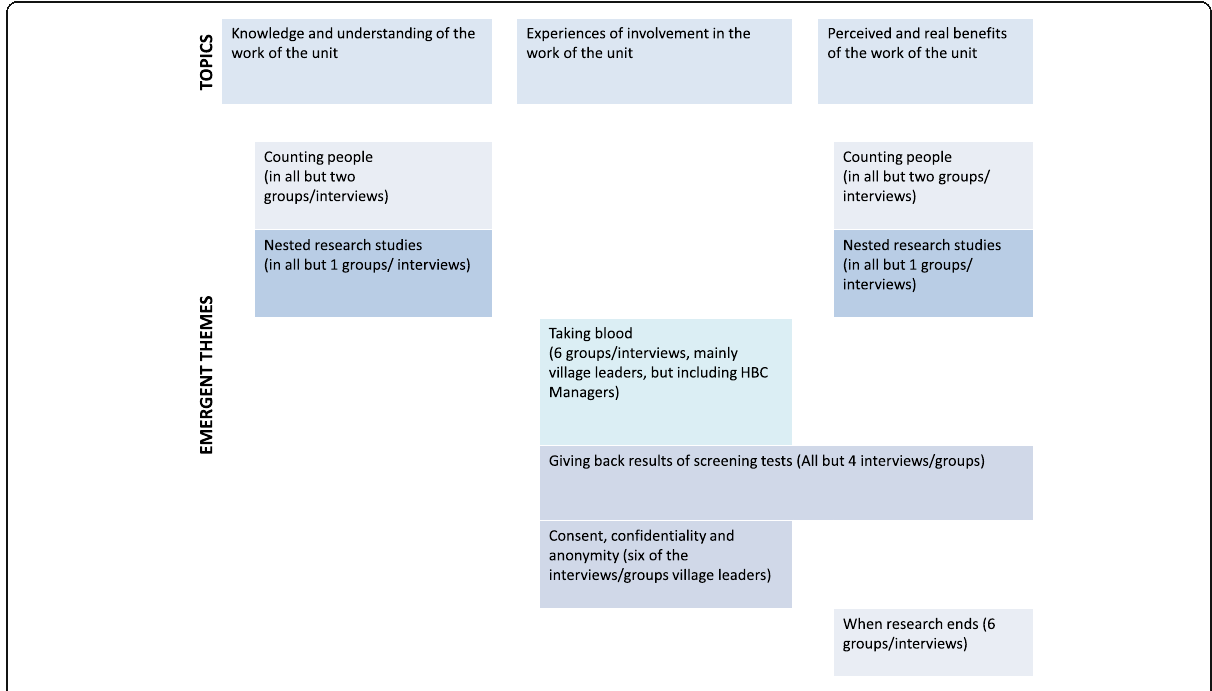
Fig. 2 Themes emerging from topics, discussed by which participant